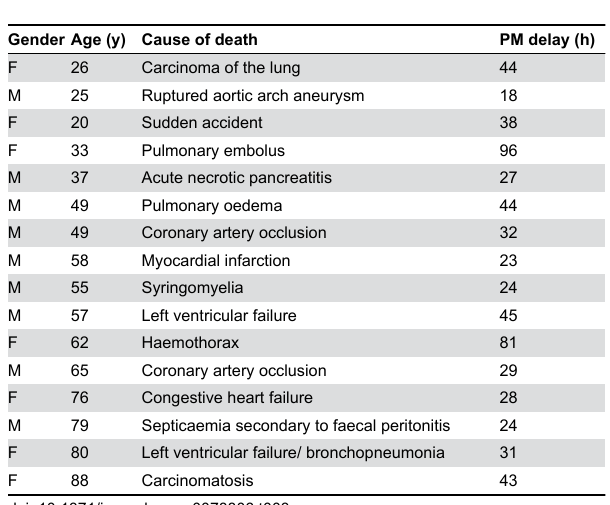
Table 3. Characteristics of the series of non-dementia brains covering a wide spectrum of ages used in the study.